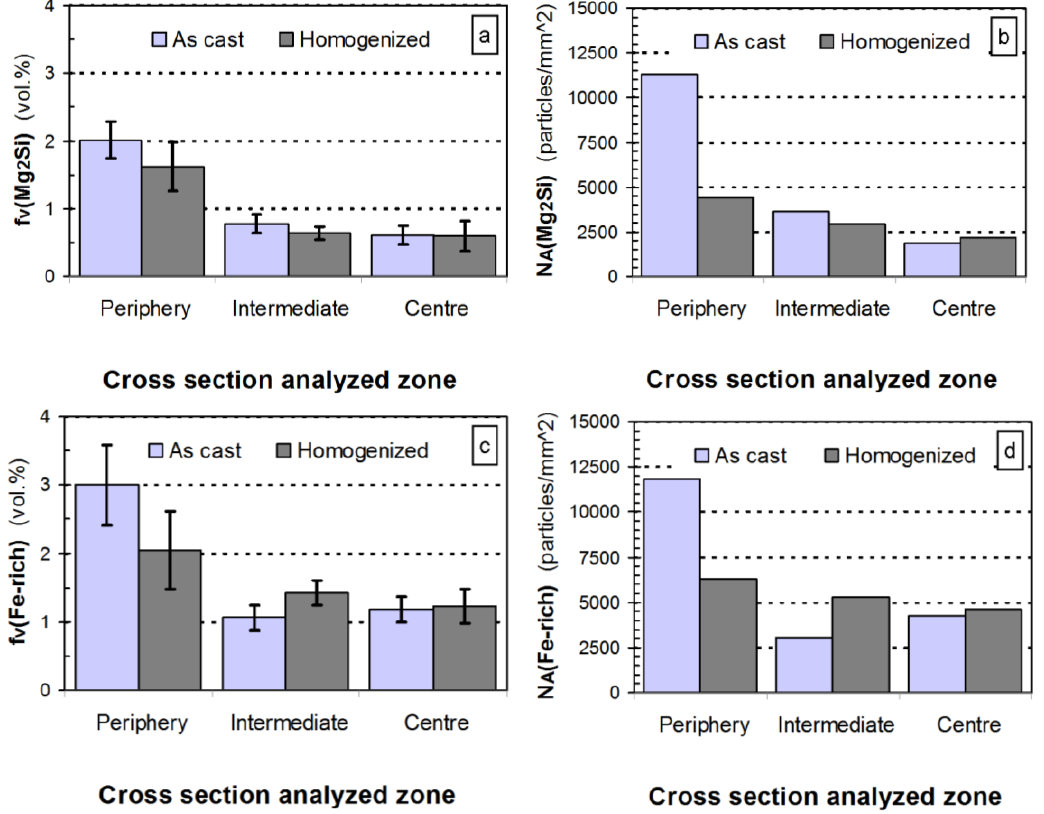
Figure 4. Quantitative determinations conducted in selected zones of the cross section of the billet. Samples were analyzed in both the as-cast state and after homogenizing. The determinations for Mg Si particles are: ( a ) volume fraction, f ; and ( b ) particle density 2 v in the area, N . And the determinations for AlFeSi intermetallics were also; ( c ) volume A fraction, f ; and ( d ) areal particle density, N . Error bars represent the 95% confidence v A limit of the